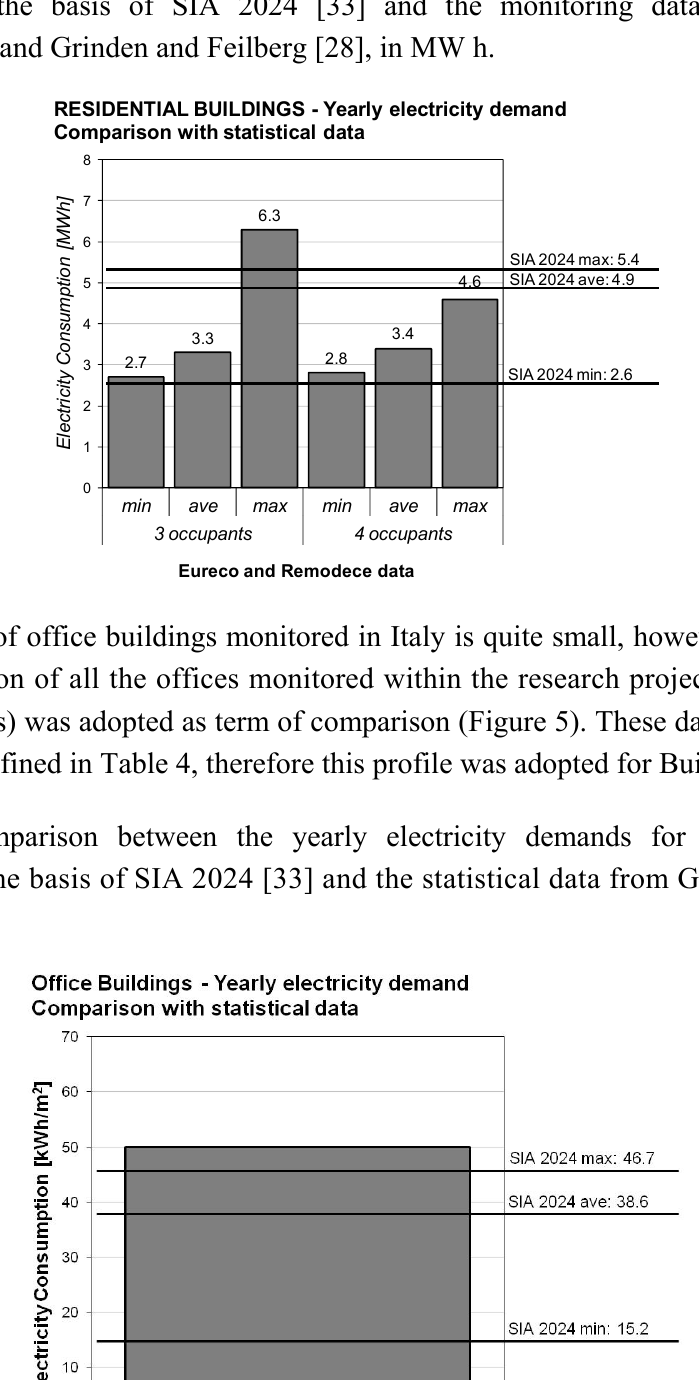
Figure 4. Comparison between the yearly electricity demands for residential buildings elaborated on the basis of SIA 2024 [33] and the monitoring data extracted from Alari et al. [27] and Grinden and Feilberg [28], in MW h.